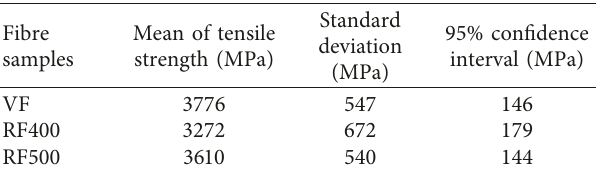
Table 3: Statistical parameters of normal distributions obtained from single fibre tensile tests analysis and related 95% confidence intervals.